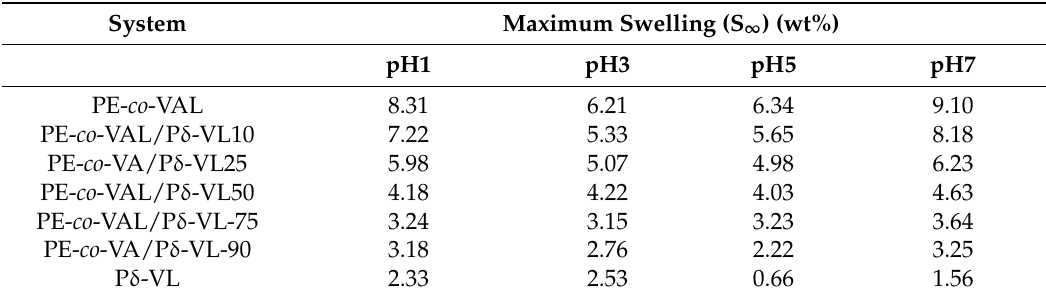
Table 4. Data of the maximum swelling degree of PE- co -VAL/P δ -VL hydrogels and their components in different media pH and at 37 ◦